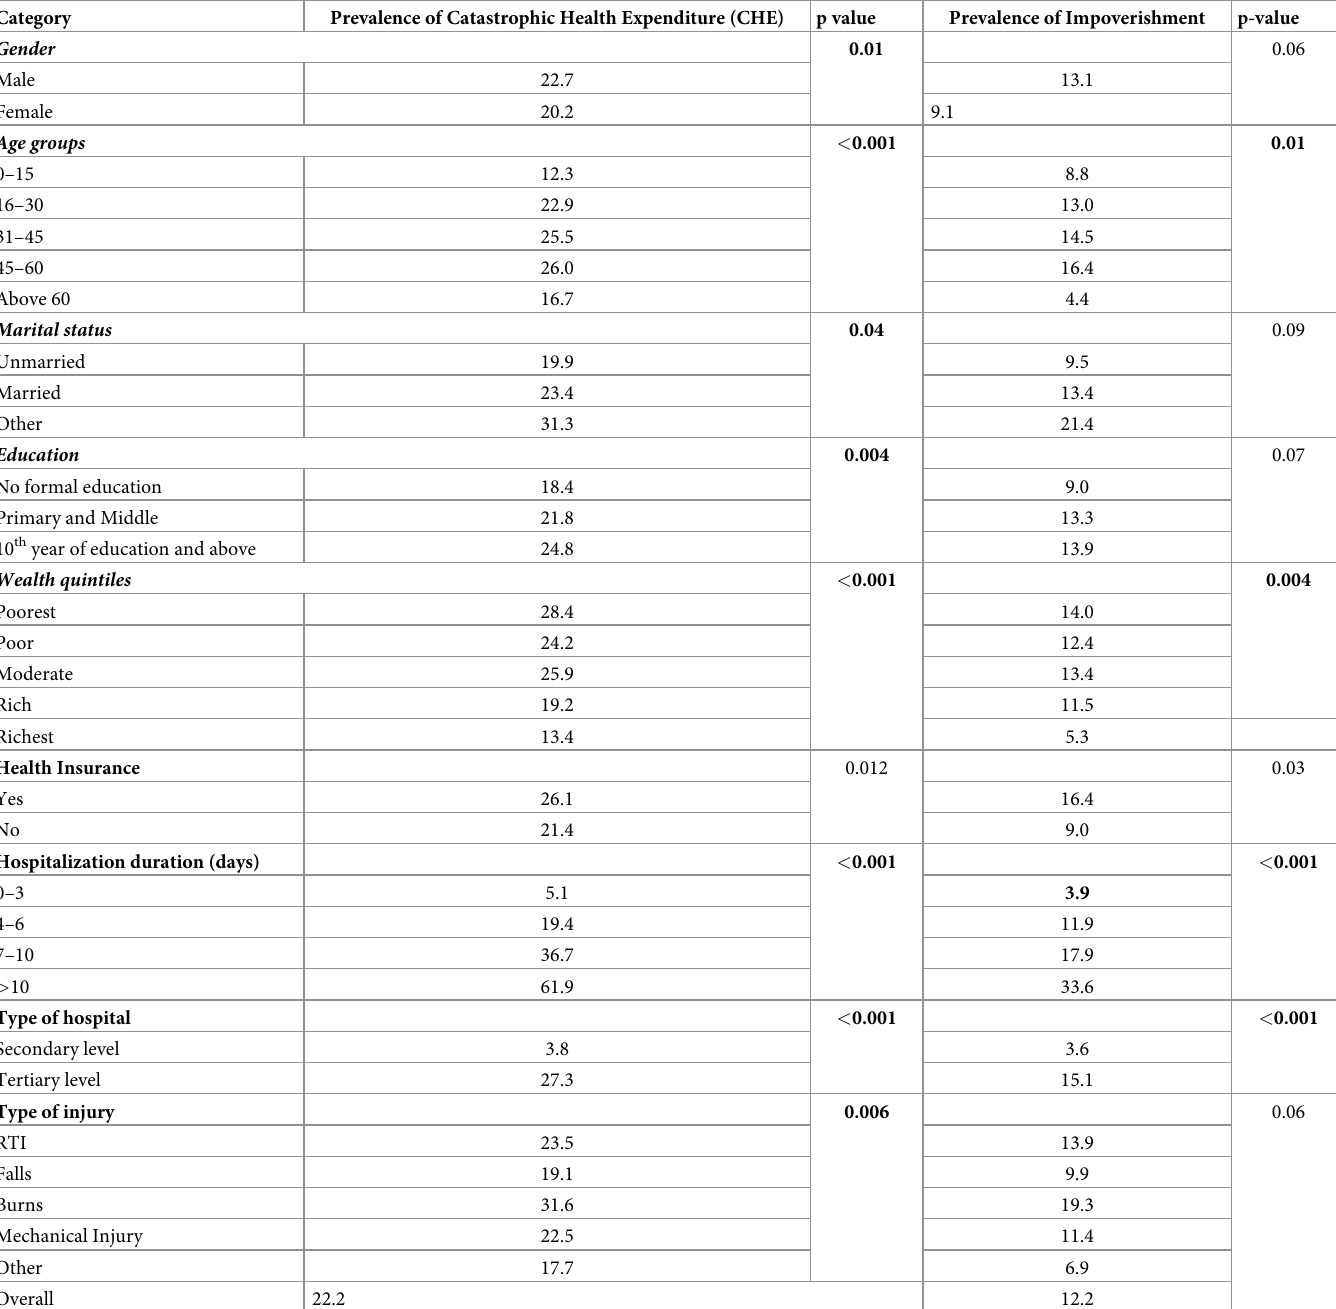
Table 5. Prevalence of catastrophic health expenditure and impoverishment among injury-related hospitalization.